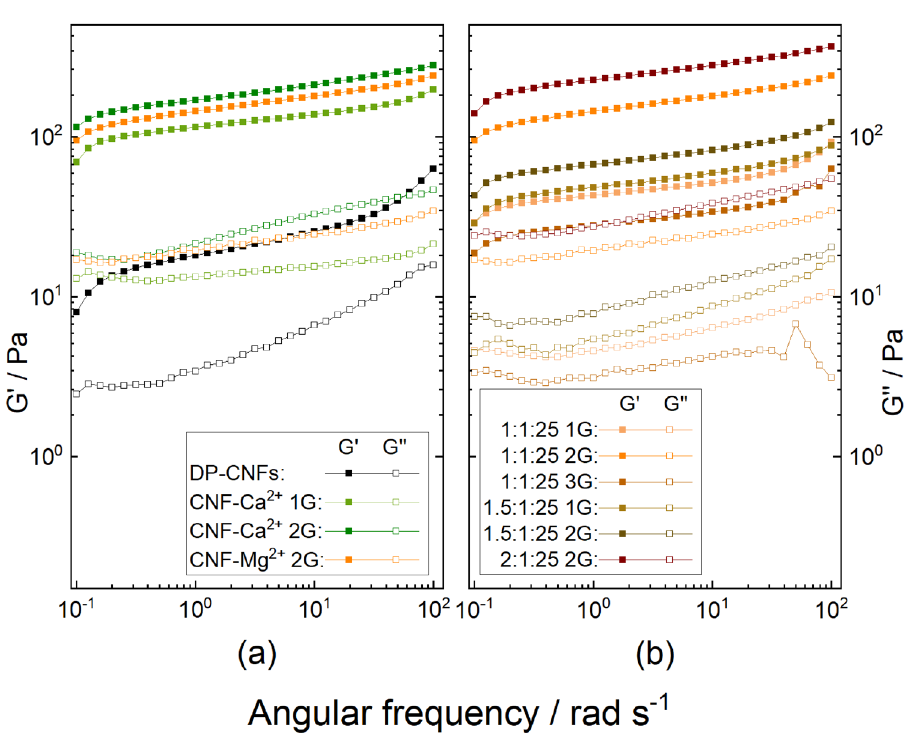
Figure 5. Viscoelastic properties of the deprotonated TOCNF dispersion and the hydrogels prepared from various divalent cations concentrations and centrifuging intensity: ( a ) hydrogels with defined ratio of M 2+ :TOCNF:H 2 O = 1:1:25 centrifuged with 1 × G and 2 × G, ( b ) TOCNF–Mg 2+ with various Mg 2+ concentrations and centrifuging intensities. Storage modulus (G ′ ) and loss modulus (G ″ ) are symbolized with filled and open symbols,